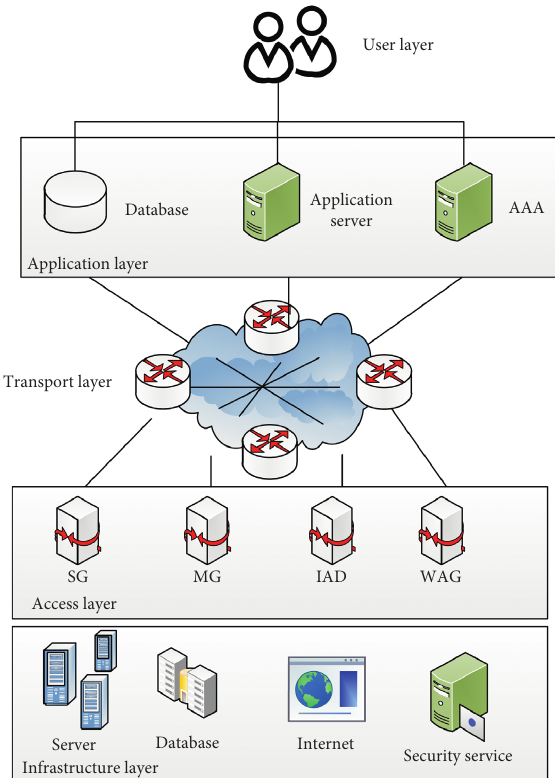
Figure 1: Overall structure of cloud audit platform for social security